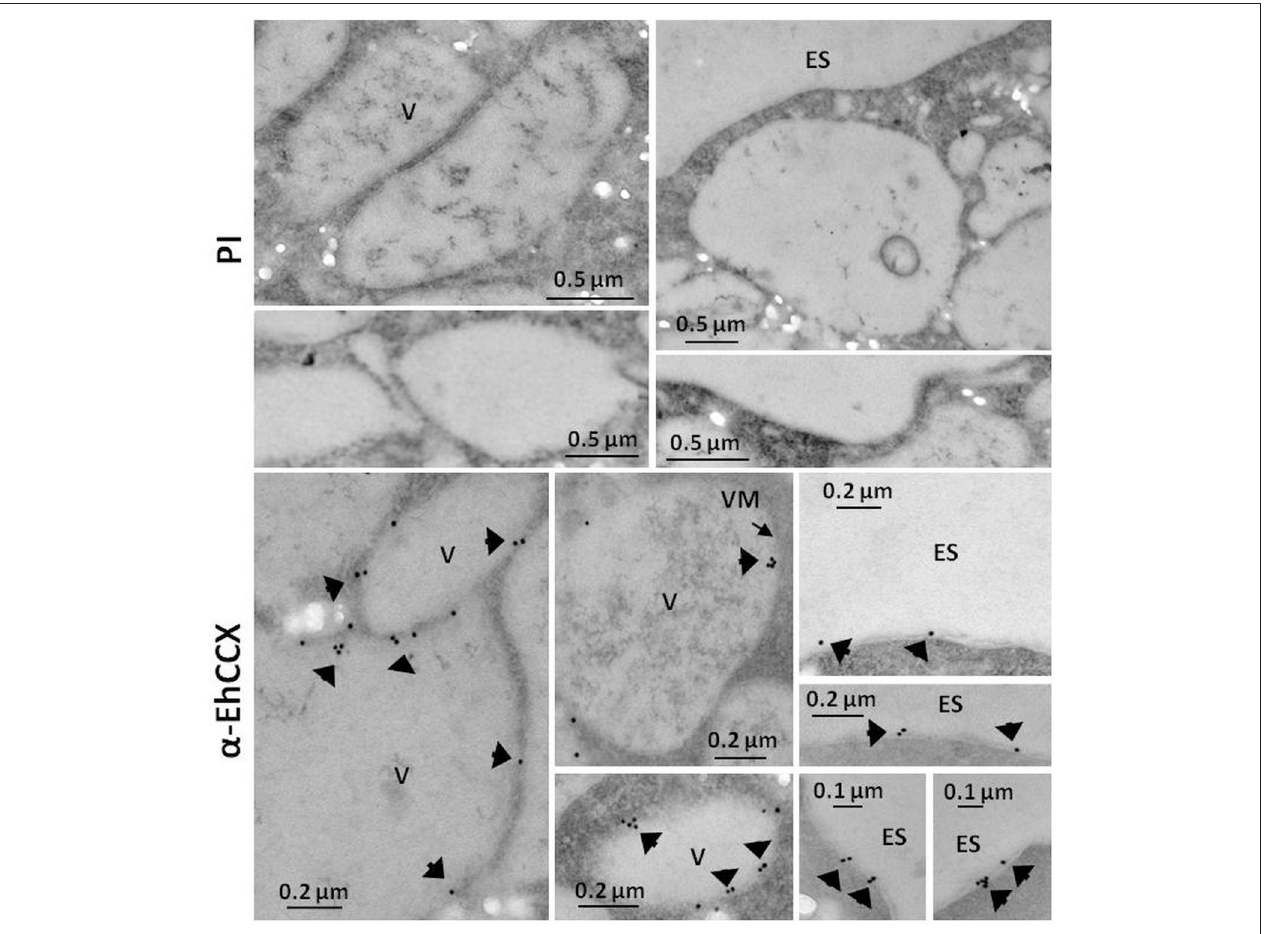
FIGURE 4 | Immunoelectron microscopy. Thin sections (60nm) of trophozoites were incubated with pre-immune serum (PI) or with antibodies against EhCCX ( α -EhCCX) and then, with anti-rat IgGs conjugated to 15nm gold particles. Afterwards, samples were analyzed by transmission electron microscopy. ES, extracellular space; V,